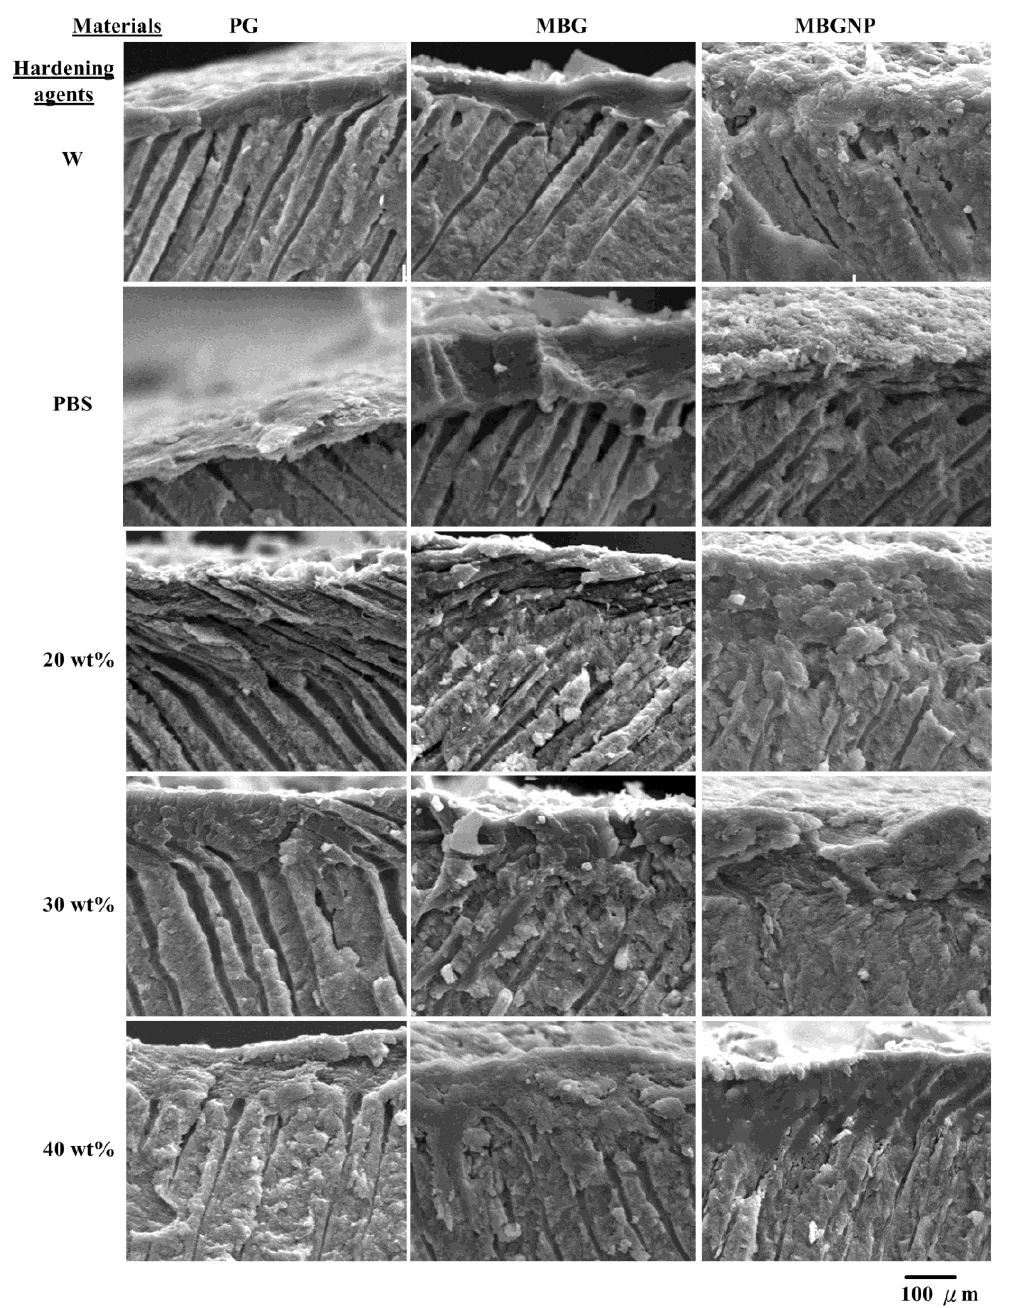
Figure 3. SEM micrographs of dentinal tubules cross-sectional morphologies treated with different materials of PG, MBG and MBGNP reacted with various hardening solutions for 5 min at a magnification of 1000×. (W: de-ionized water; 20PA, 30PA and 40PA: respective 20, 30 and 40 wt %